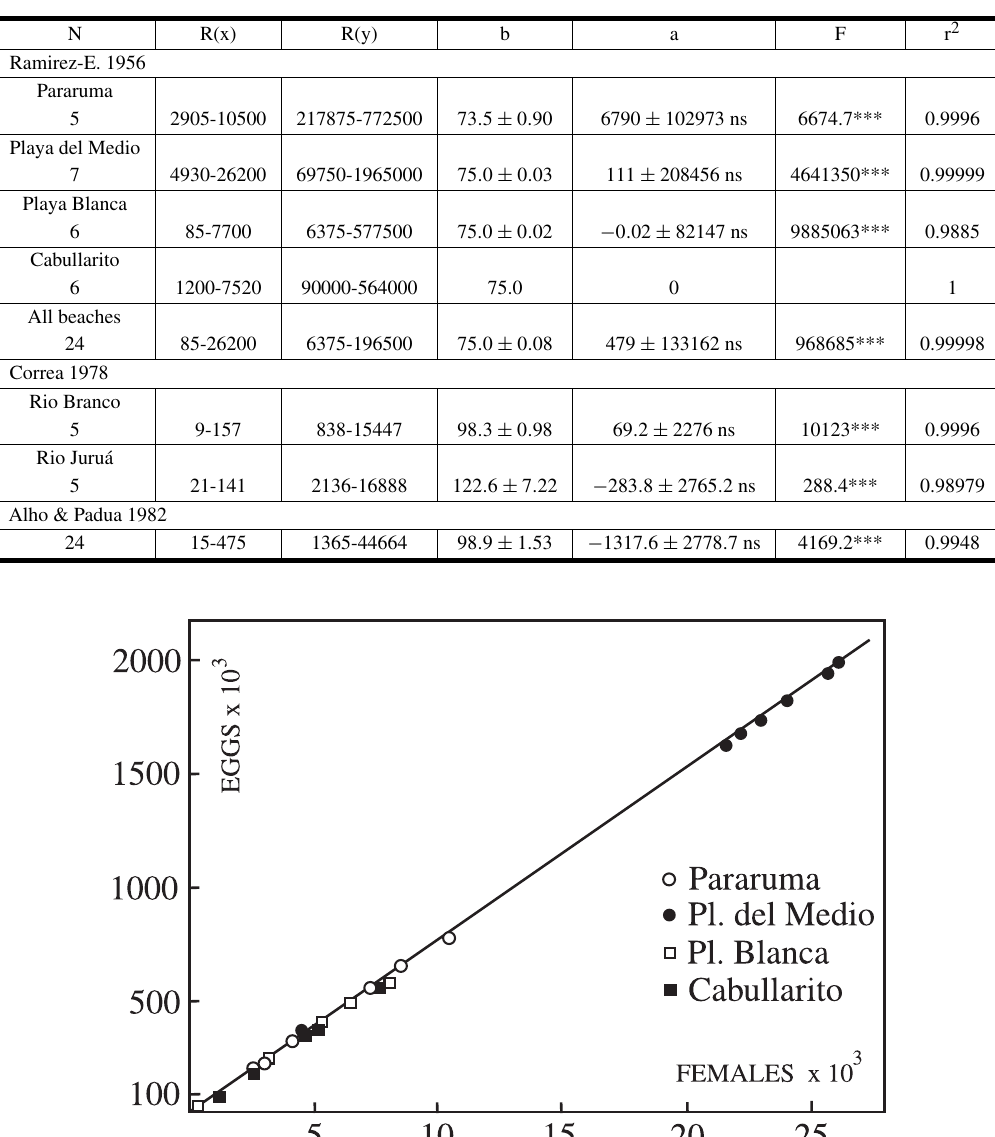
Podocnemis expansa , regression of the number of eggs on the number of females or nests.